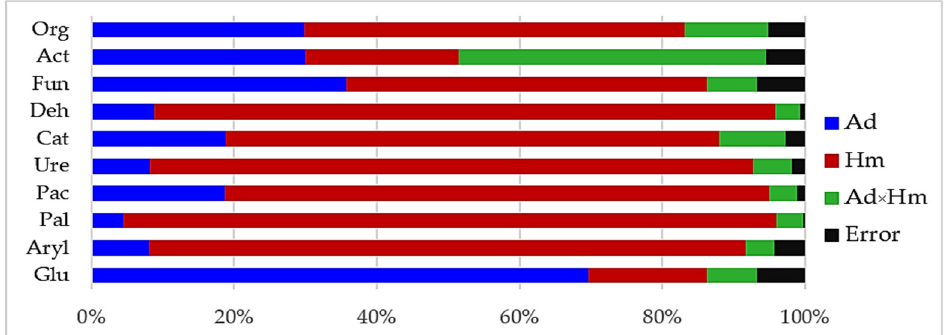
Figure 1. Contribution of independent variables on the number of microorganisms and activity